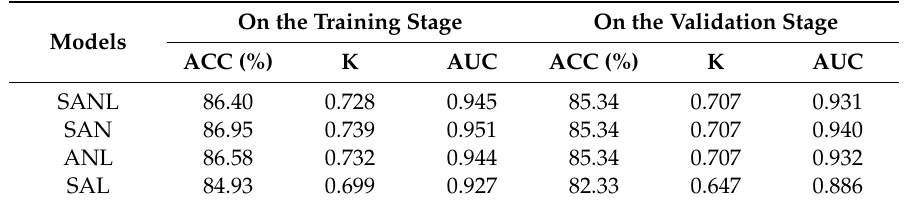
Table 4. Performance evaluation of landslide models. AUC: the area under the receiver operating characteristic (ROC) curve; K: Kappa coefficient.